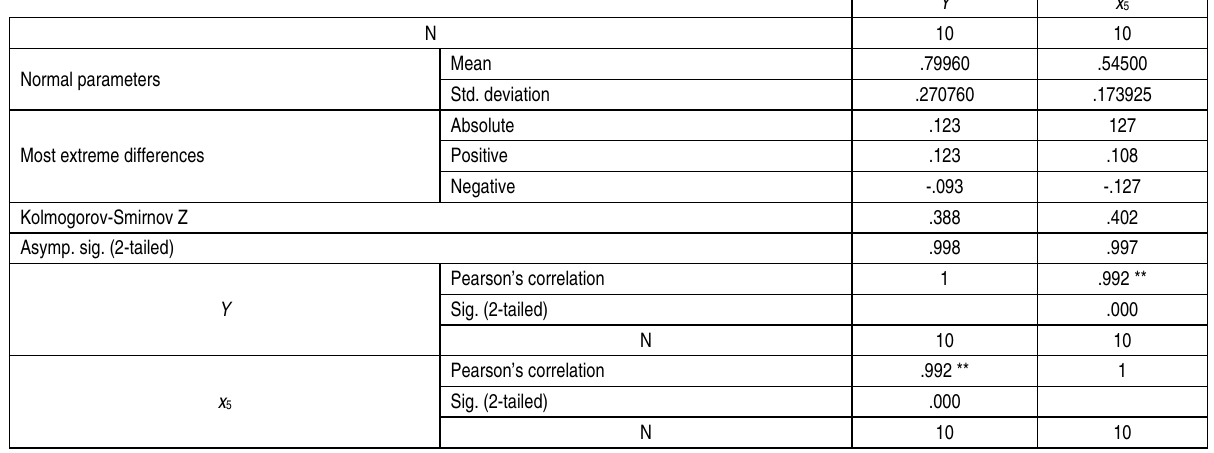
Table 17. The fifth hypothesis test result (normality test and correlation analysis)